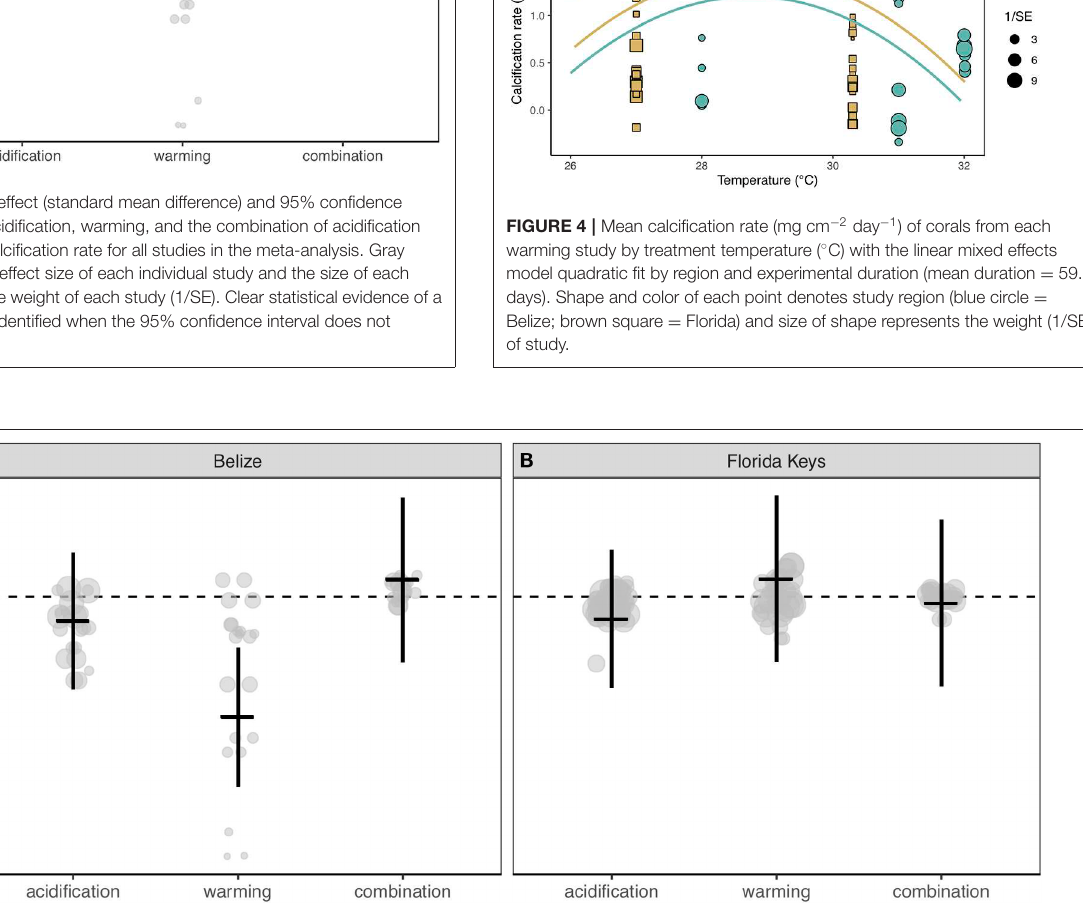
Frontiers in Marine Science |